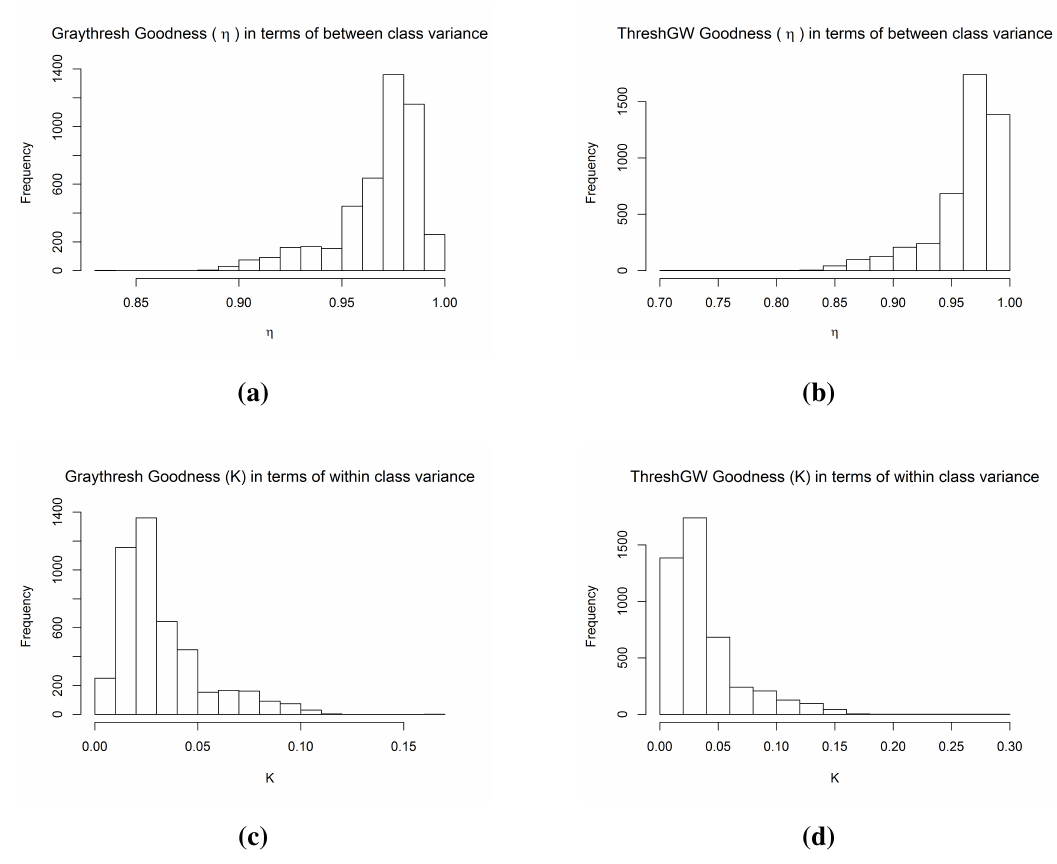
Figure 8. Histogram of K and (cid:17) for checking the goodness of ThreshGW and graythresh. ( a ) Graythresh ( (cid:17) ); ( b ) ThreshGW ( (cid:17) ); ( c ) graythresh (K); ( d ) ThreshGW